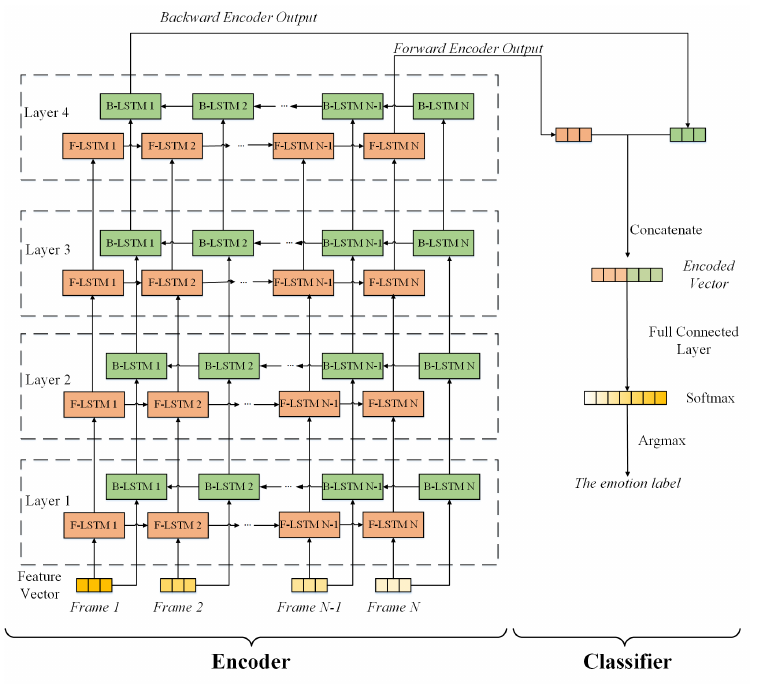
Figure 4. The structure of the student speech emotion recognition model based on 4-layer